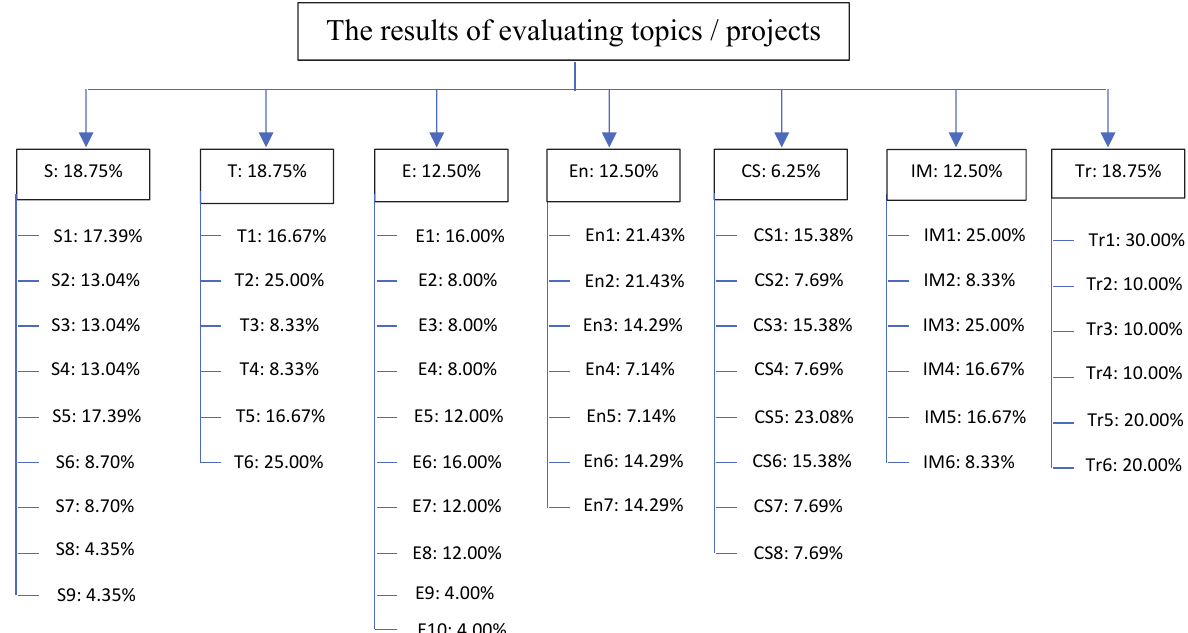
Fig. 6. Weight of each criterion for evaluating socio-economic efficiency of engineering and technological sciences topics